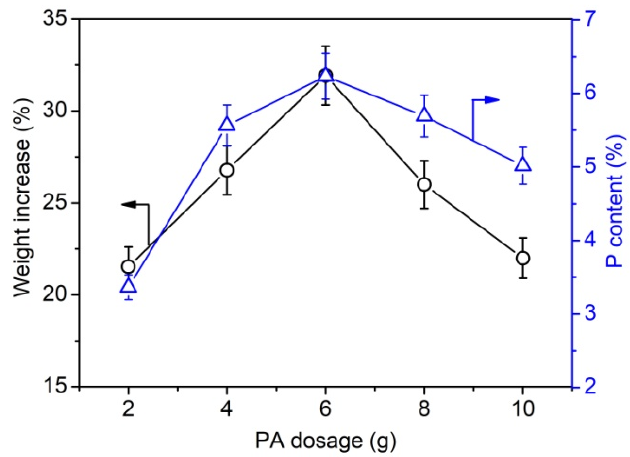
Figure 2. Weight increase percentage and phosphorus content of phosphorylated KF samples prepared using various dosages of PA (PA 2–6 g, urea 6 g, 150 ◦ C, and 90 min).